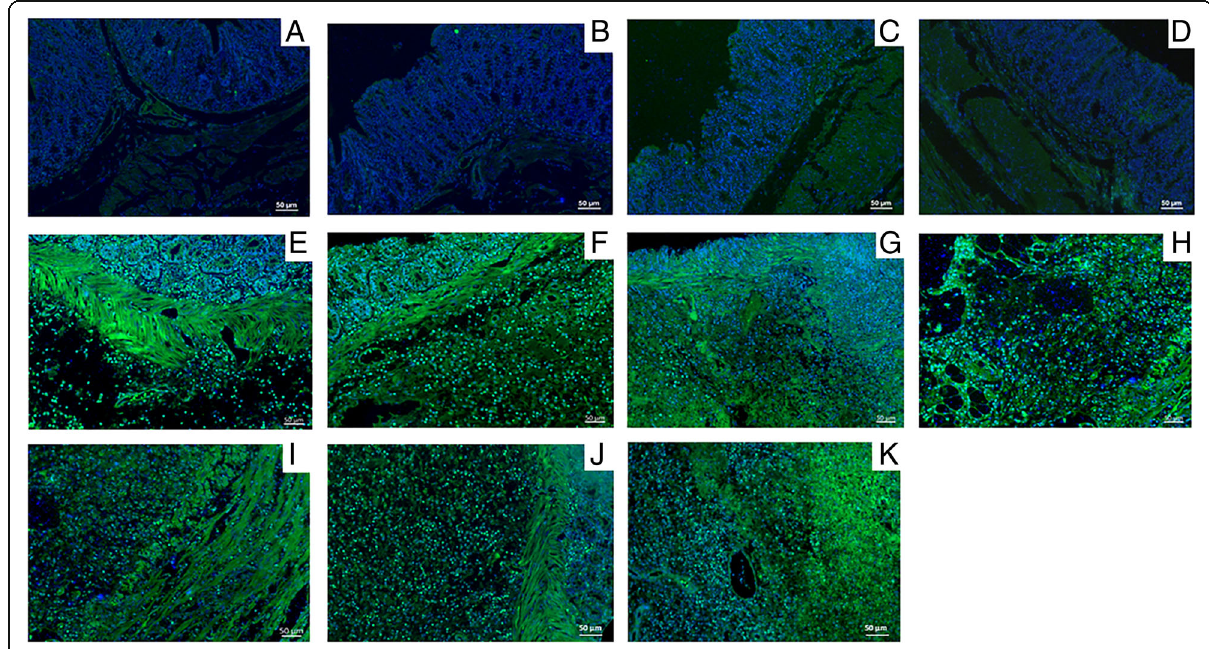
Fig. 3 Anti-COX-2 IF images of colon samples from the saline (negative control) and the acetic acid-induced UC groups stained with green fluorescent compounds (ALEXA, AuNPs, or both) and DAPI (blue) for nuclei. a Negative control stained with ALEXA standard protocol (A1) with anti-COX-2 and ALEXA (green). b Negative control stained with modified ALEXA protocol (A2) with anti-COX-2 and ALEXA. c Negative control stained with nanoparticle protocol 1 (NP1) with anti-COX-2 and AuNPs (green) instead of ALEXA. d Negative control stained with nanoparticle protocol 2 (NP2) with anti-COX-2 and AuNPs instead of ALEXA. e Positive control stained with A1. f Positive control stained with A2. g Positive control stained with NP1. h Positive control stained with NP2. i Positive control stained with nanoparticle protocol (NP3) with anti-COX-2+AuNPs with 1:200 ALEXA. j Positive control stained with NP3 (with 1:400 dilution of ALEXA). k UC positive control stained with NP3 (with 1:800 dilution of ALEXA). Magnifications, ×200. Scale bar=50 μ